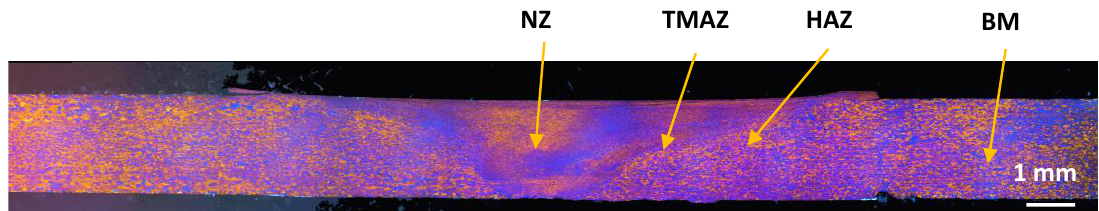
Figure 2. Typical optical microscopy macrograph showing various microstructural zones in a FSW joint in AA6082-T6 aluminum alloy (blanks thickness = 2 mm, truncated cone pin tool with shoulder diameter = 12 mm, ω = 1200 rpm and v = 100 mm/min).